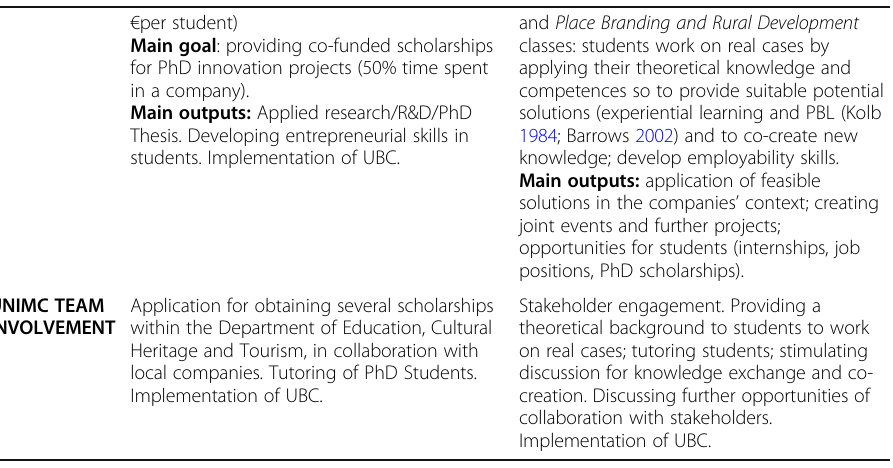
Table 2 Overview about the projects representing UNIMC ’ s civic engagement (own elaboration)